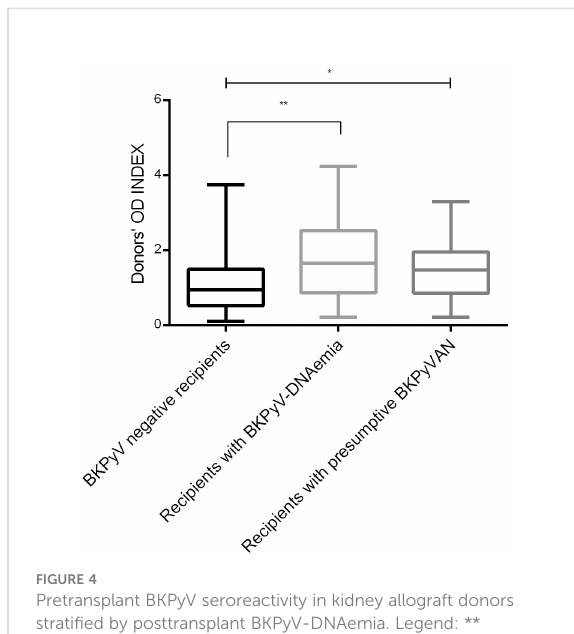
FIGURE 5 Pretransplant BKPyV seroreactivity among kidney allograft donors of BKPyV- negative recipients and those with posttranplant BKPyVAN. Legend: p=0.058, donors ’ OD INDEX represent the ratio of the absorbance of a sample to the respective CO value; donors were divided according to posttransplant